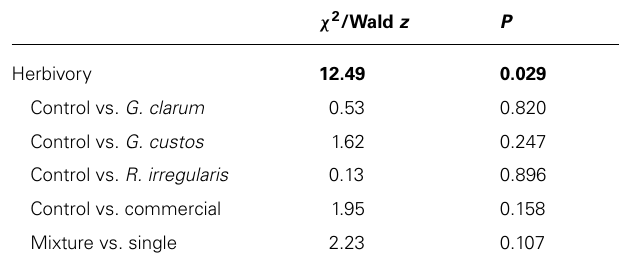
Table 4 | Results of GLMM analyses ofAMF treatment effects on